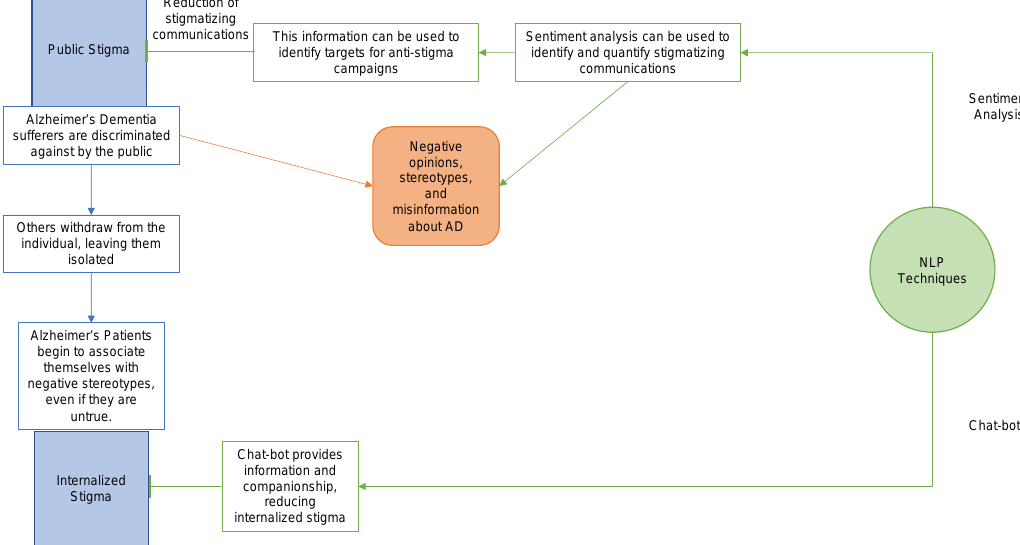
Figure 1. Summary of proposed NLP applications. We propose that an NLP-based sentiment analysis could be used to identify the need for and facilitate the deployment of anti-stigma measures aimed at minimizing public stigma towards Alzheimer’s dementia and other dementia patients. A chat-bot/AI companion implementation would aid in the independent living of AD patients while alleviating social isolation and the feelings of loneliness that exacerbate self-stigma.